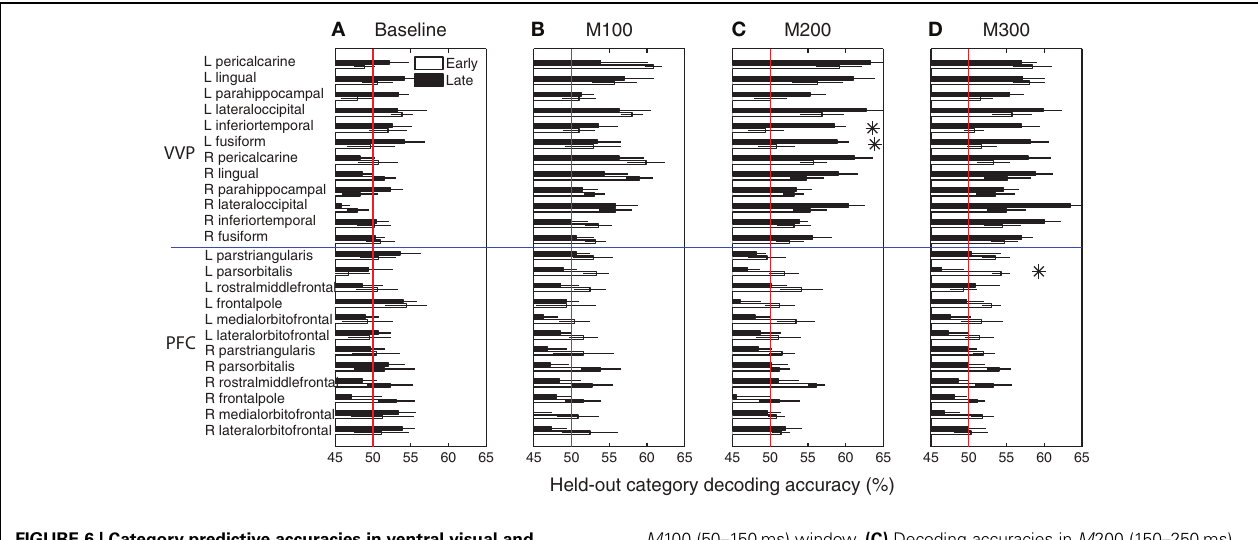
FIGURE 6 | Category predictive accuracies in ventral visual and prefrontal cortices. (A) Group-average blob category predictive accuracies in 24 ventral visual and prefrontal cortical regions based on dipole activities in 0–50ms after onset during early and late learning. (B) Decoding accuracies in